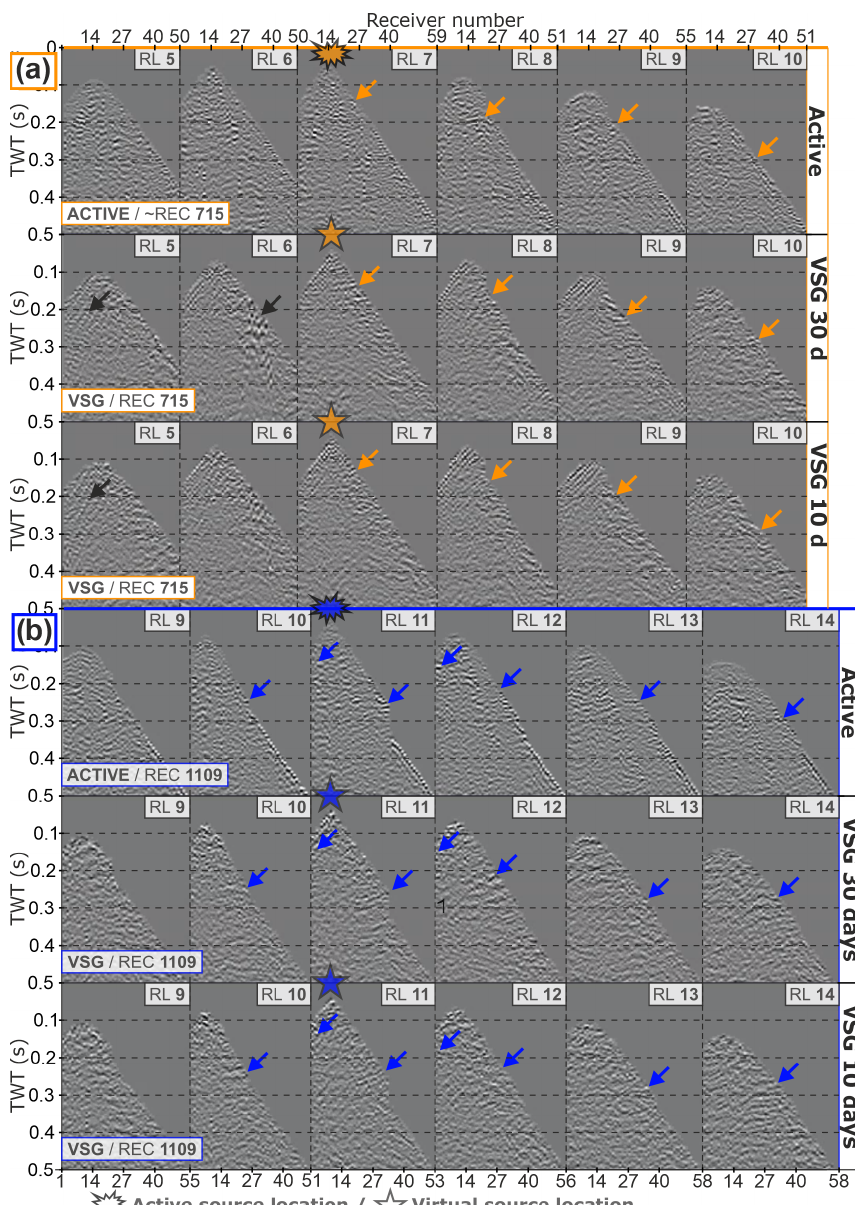
Figure 6. Comparison of exemplary co-located 3D common-source gathers using active and passive data. The active-shot gathers are filtered using a bandpass filter (25–35–90–120Hz) to have the frequency content of the passive data. For each gather, we show six receiver lines (RLs). (a) Common-source gathers co-located with receiver station 715: (top row) active-shot gather, (middle row) VSGs obtained using 30d of noise, and (bottom row) VSGs obtained using 10d of noise. (b) Common source gathers co-located with receiver station 1109: (top row) active-shot gather, (middle row) VSGs obtained using 30d of noise, and (bottom row) VSGs obtained using 10d of noise. (a) The orange and (b) blue arrows on both active and passive data highlight the position of reflection arrivals observed in active-source data and projected on co-located VSGs. Black arrows indicate artifacts characteristic for passive data. TWT stands for two-way travel time.